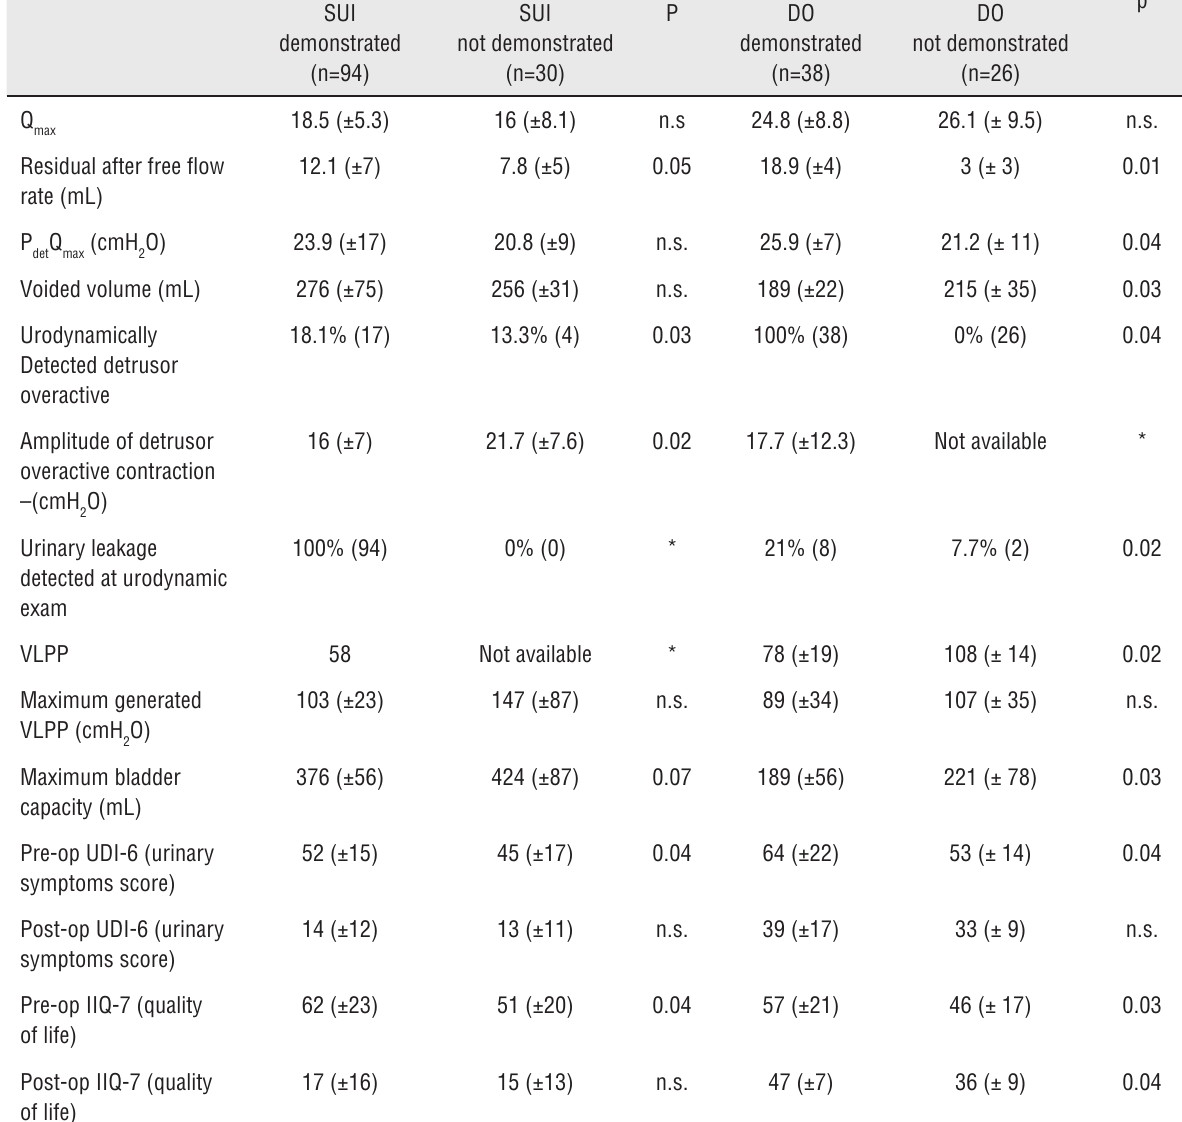
Table 2 - Urodynamic findings of 2 arm groups of women submitted to urodynamic evaluation treated for SUI or OAB. SUI